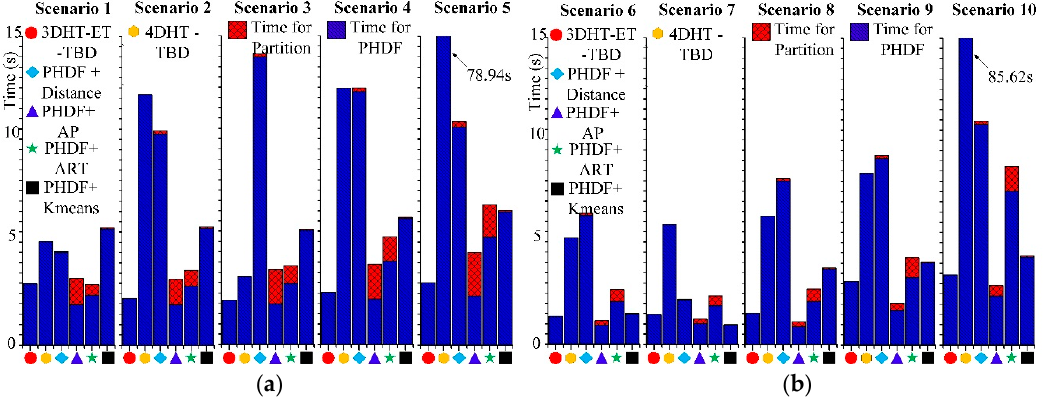
Figure 5. ( a ) The average computation time of scenarios 1–5. ( b ) The average computation time of scenarios 6–10.